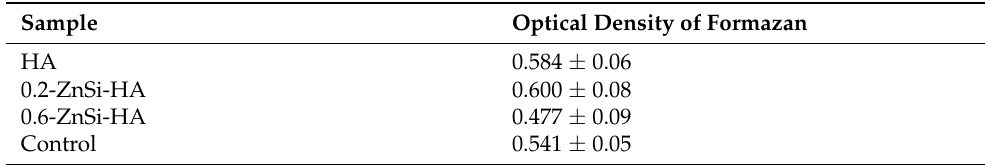
Table 3. MTT assay results after 4-day incubation of MG-63 cell with HA powders. Optical density of formazan inversely correlated with cell death.